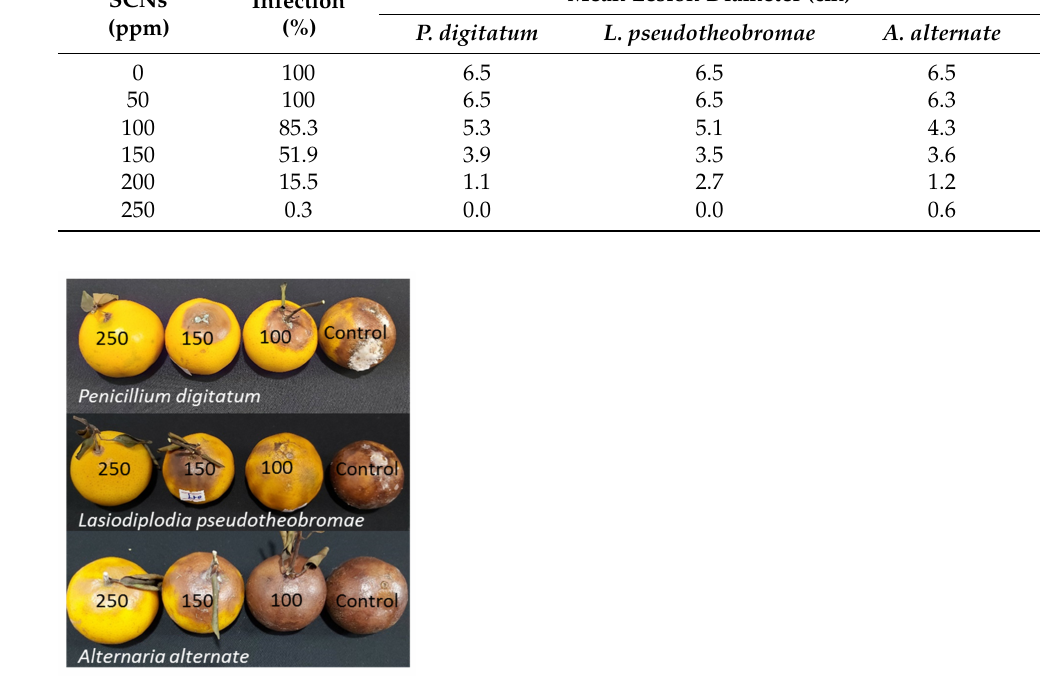
Figure 10. The antifungal activity of SCNs against three fungi on Citrus reticulata Blanco after being treated for a